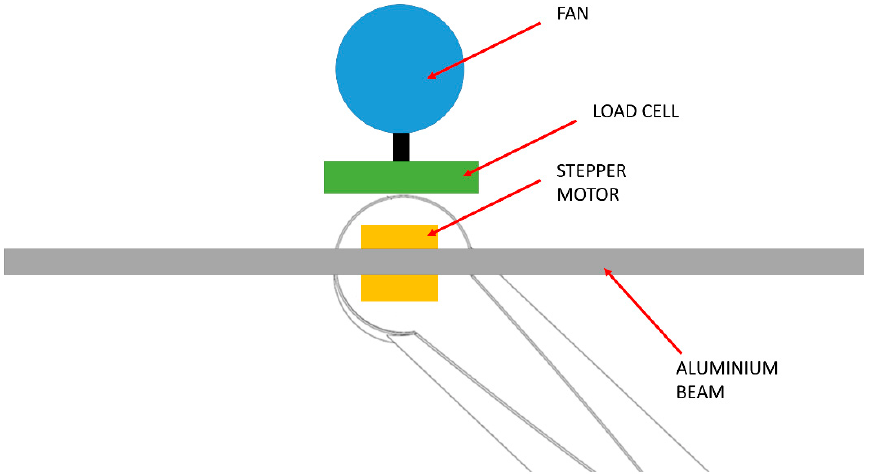
Figure 6. Schematic front elevation of the configuration at each hub. Analogous to the right hand image in Figure 3.